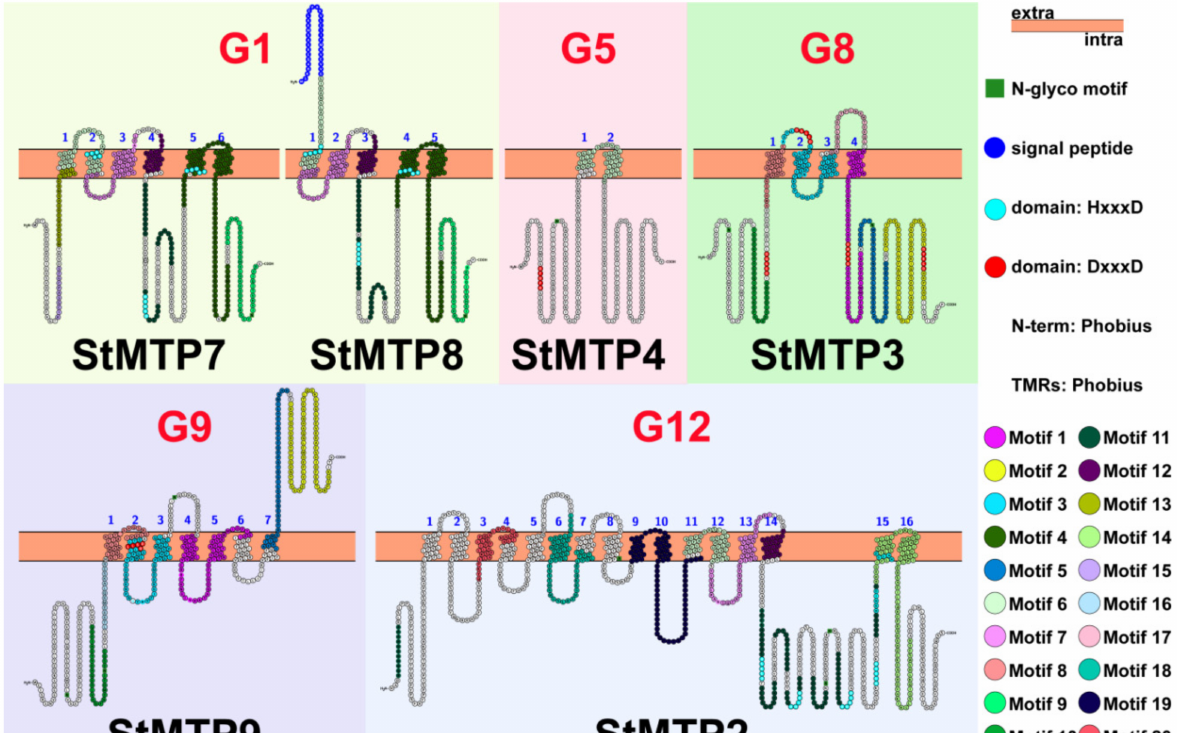
Figure 5. StMTPs protein sequence analysis. The orange box represents the biofilm. Different motifs are represented by circles (black fonts) of corresponding colors, The blue number indicates the number of the transmembrane domain. HXXXD residues are represented by sky blue circles (white font), and DXXXD residues are marked by dark red circles (white font). The dark blue circle with white font indicates the presence of a single peptide in the gene. The blue number stands for the transmembrane